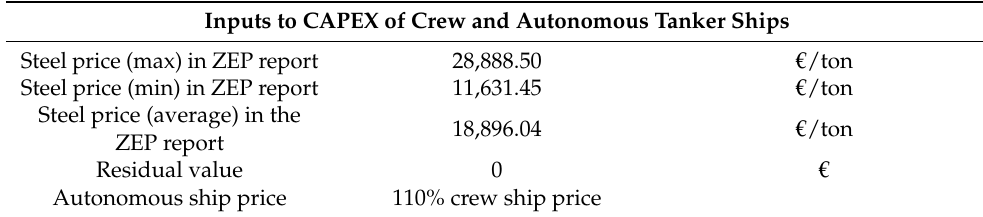
Table 12. CAPEX inputs for crew and autonomous tanker ships. Inputs to CAPEX of Crew and Autonomous Tanker